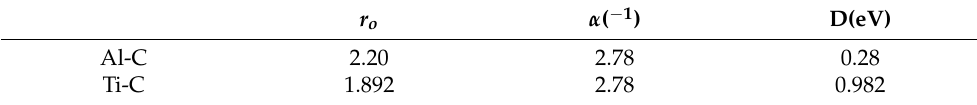
Table 3. Parameter values in Morse potential.